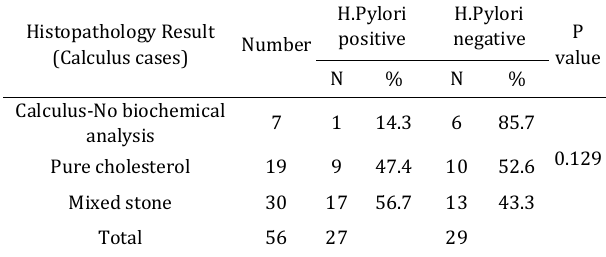
Association between Histopathology diagnosis and H.Pylori infection (Calculus & Acalculus cases).